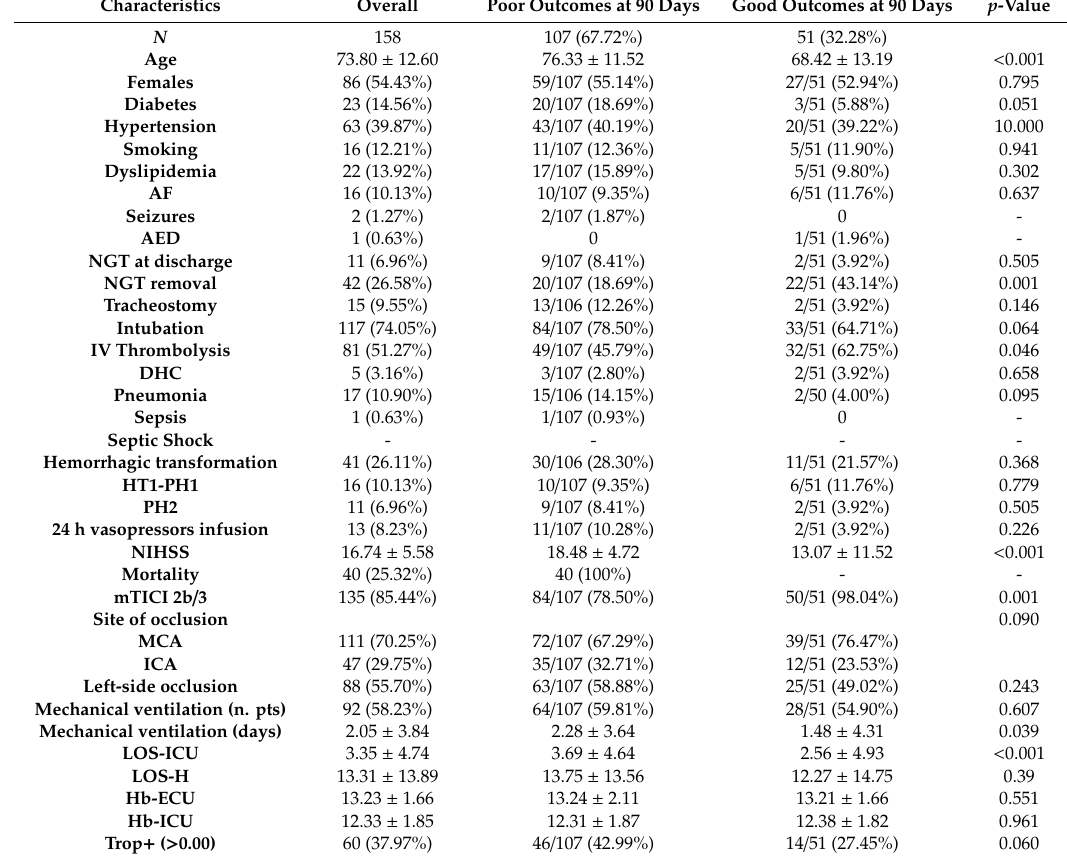
Table 1. Baseline, procedural and outcome parameters at 90-day